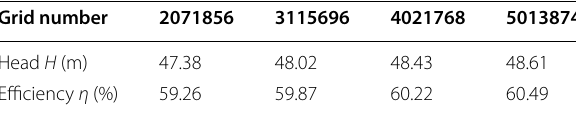
Table 2 Grid independence